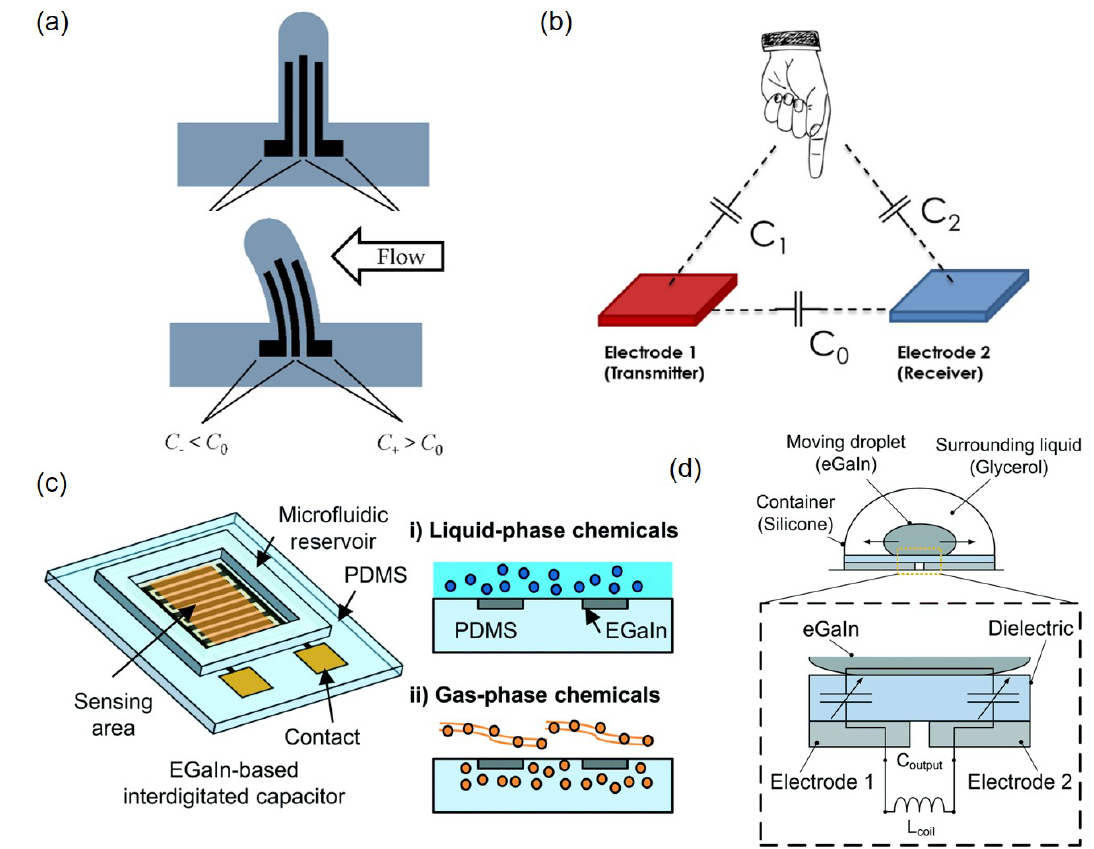
Figure 16. ( a ) Capacitance of a liquid metal sensor changes depending on the flow rate of medium. Reproduced with permission from [95]; published by MDPI, 2019. ( b ) Capacitance change due to proximity can be used to detect the distance differences. Reproduced with permission from [96]; published by MDPI, 2019. ( c ) Schematic of an EGaIn-based interdigitated capacitor with a microfluidic reservoir for sensing liquid- or gas-phase volatile organic compounds. Reproduced from Ref. [99] with permission from the Royal Society of Chemistry. ( d ) An inertial sensor using a liquid metal droplet